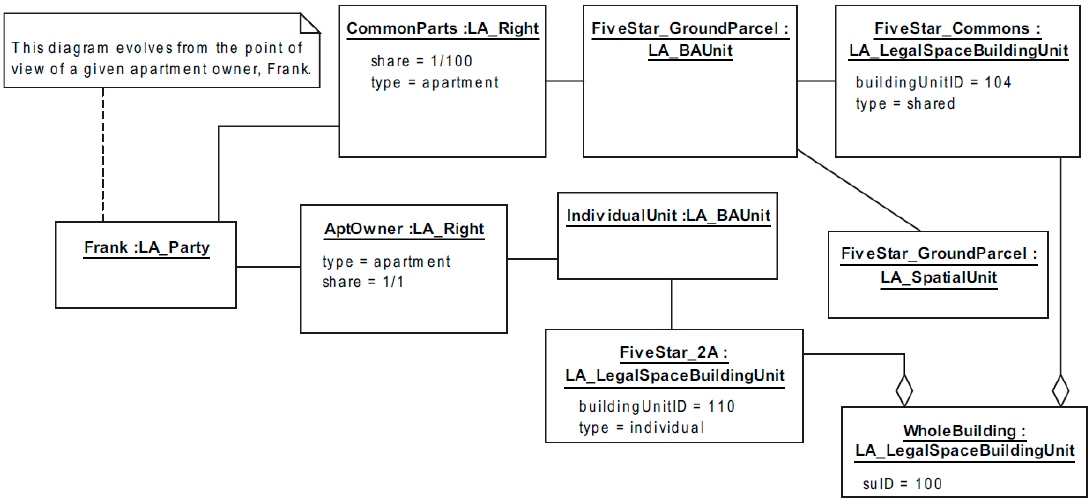
Figure 12. An apartment building in Land Administration Model (LADM) and its legal space [38].